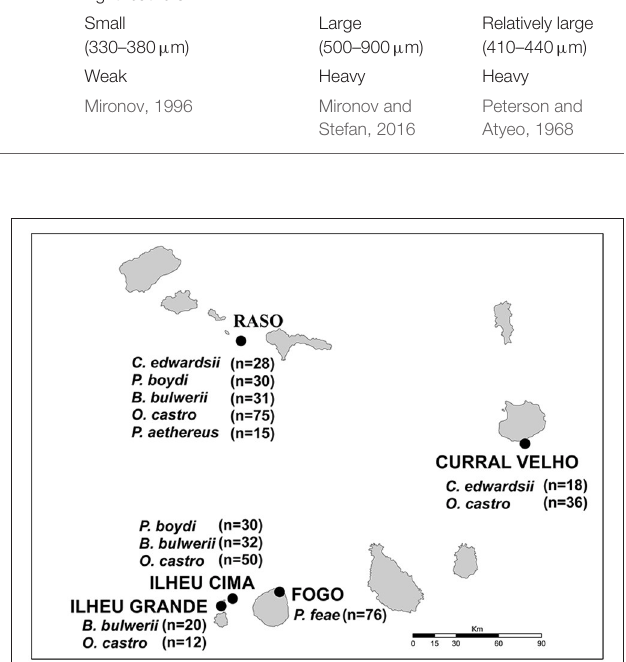
FIGURE 1 | Map of the Cape Verde Archipelago showing the five islands where feather mites were sampled. The name of seabird species and the number of dust-ruffling samples examined per host species and locality are shown in